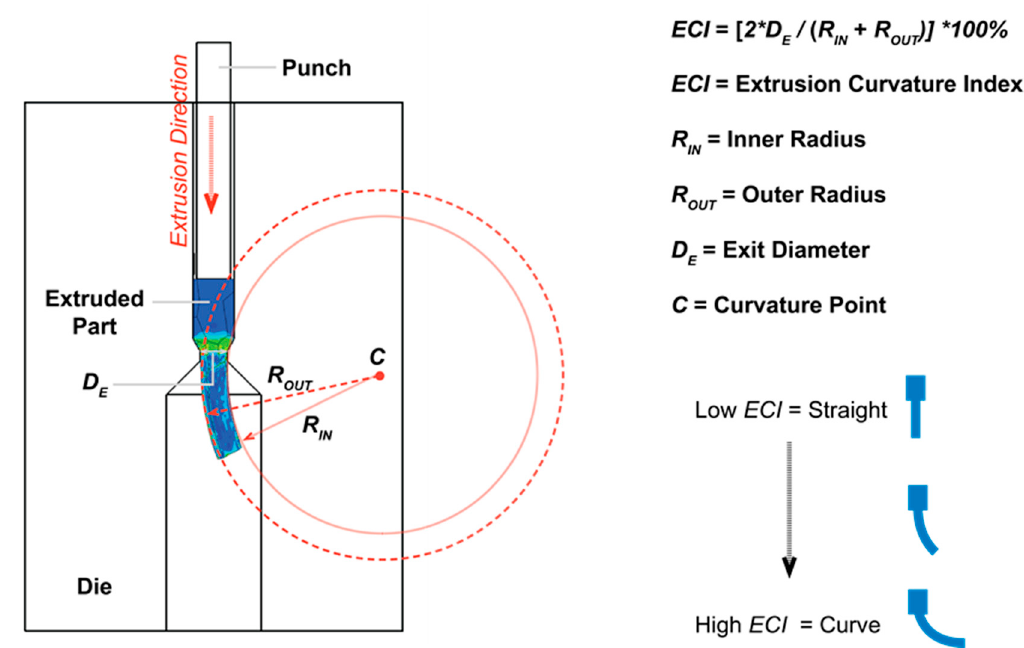
Figure 15. The schematic and calculation of the Extrusion Curvature Index ( ECI ).